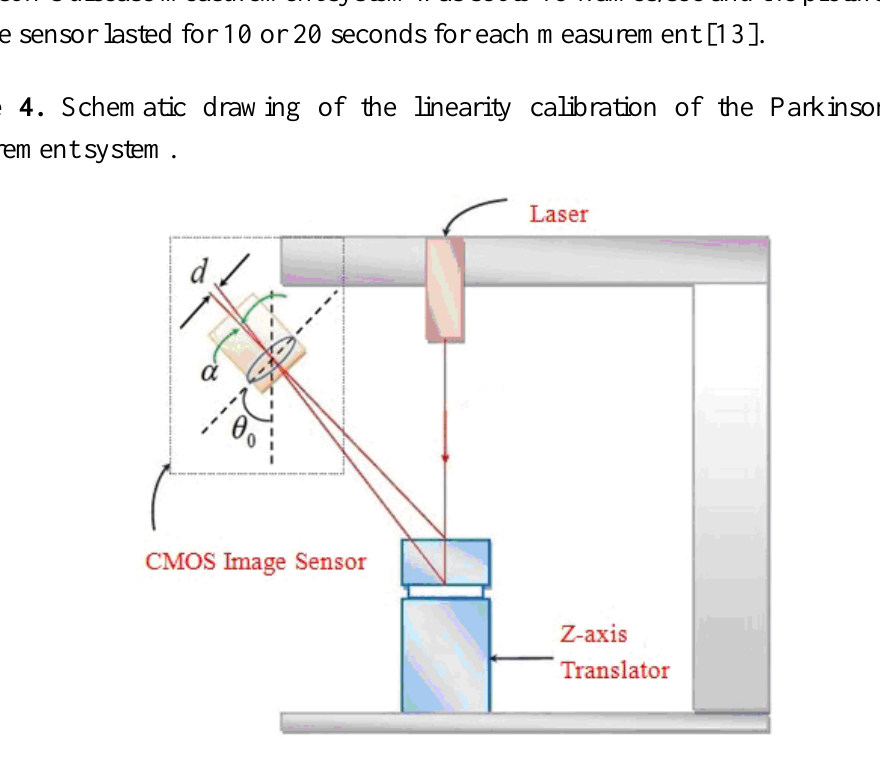
Figure 5. Calibration of the arm vibration amplitude measurement by the proposed Parkinson disease patient measurement system: (a) results for the linearity calibration experiments and (b) one standard deviation of amplitude